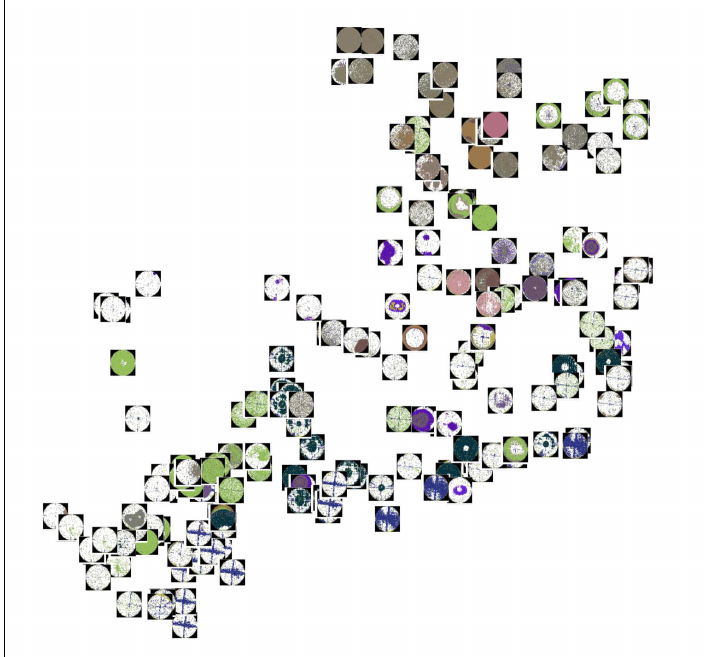
Figure 16. Visualizing bad wafers based on t-SNE and